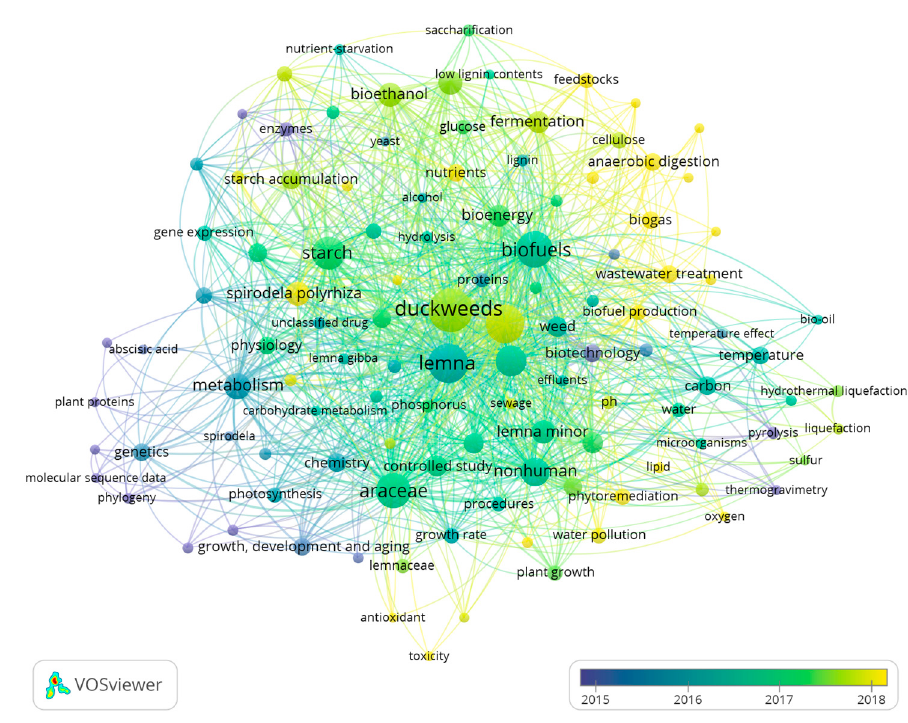
Figure 14. Co-occurrence of author’s keywords–overlay visualization.